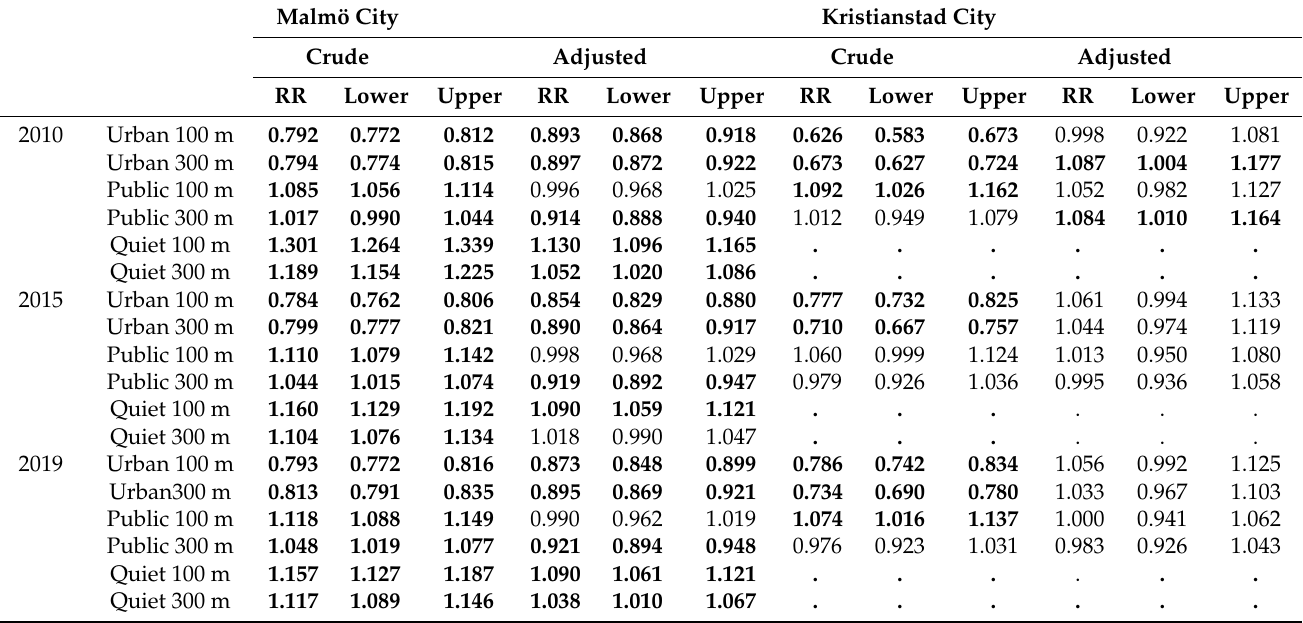
Table A4. Risk ratios for crude and multivariate associations between living alone vs cohabiting in availability in availability to total urban green space (Urban), publicly available urban green space (Public) and quiet publicly available urban green space (Quiet). RR for 100 m and 300 m buffer distances from the residence for the three different types of urban green spaces are